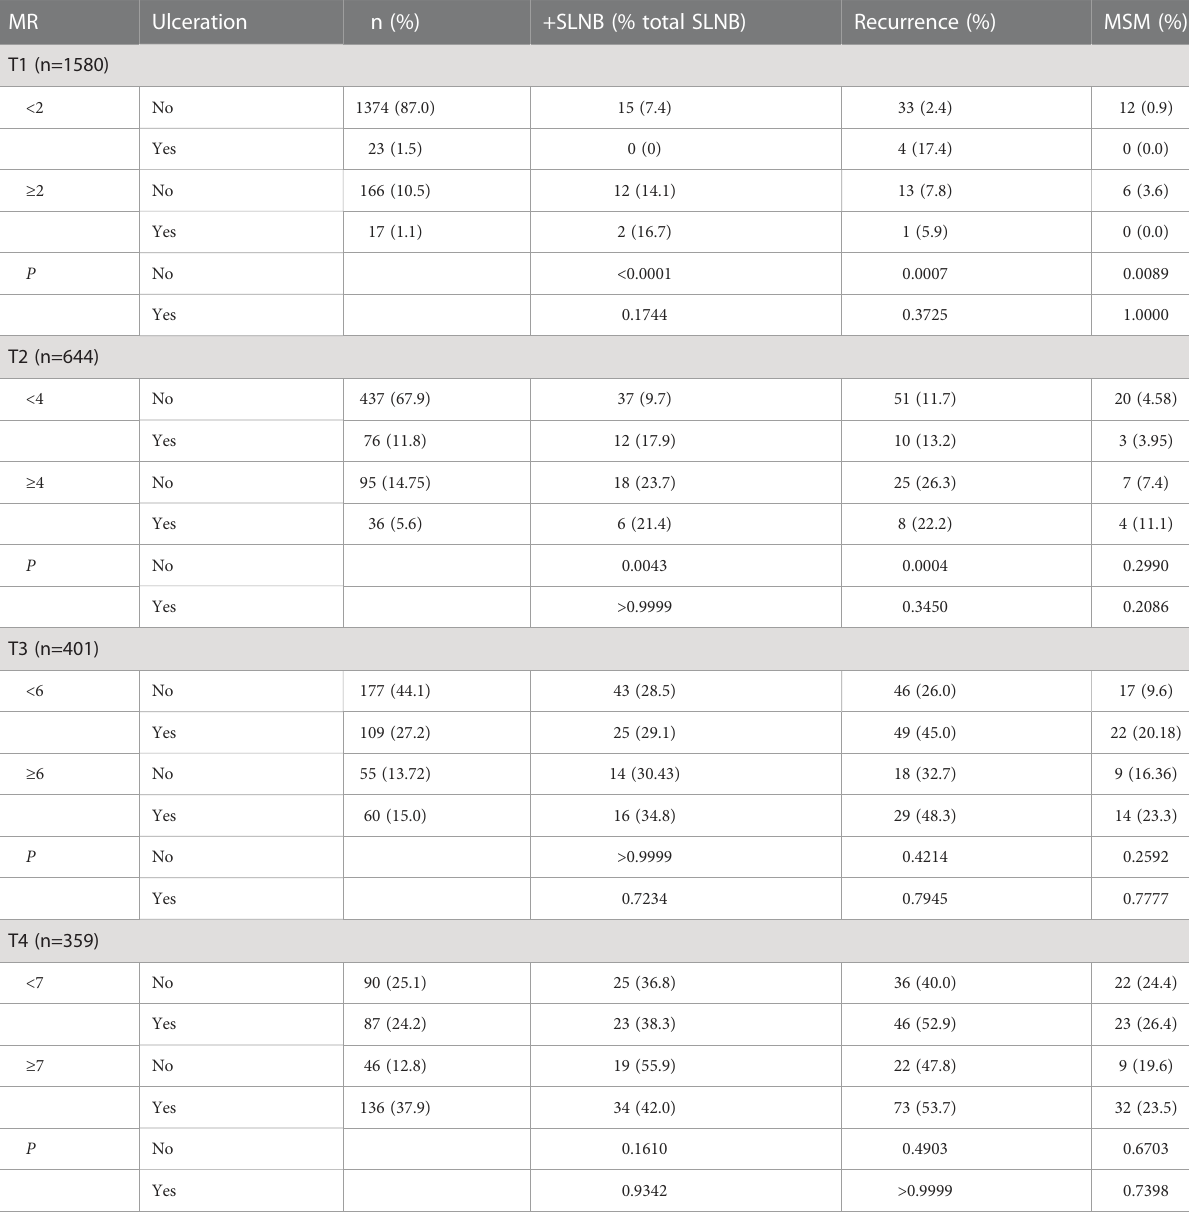
TABLE 4 Sentinel lymph node positivity, recurrence, and melanoma-speci fi c mortality among patients separated by mitotic rate and ulceration.